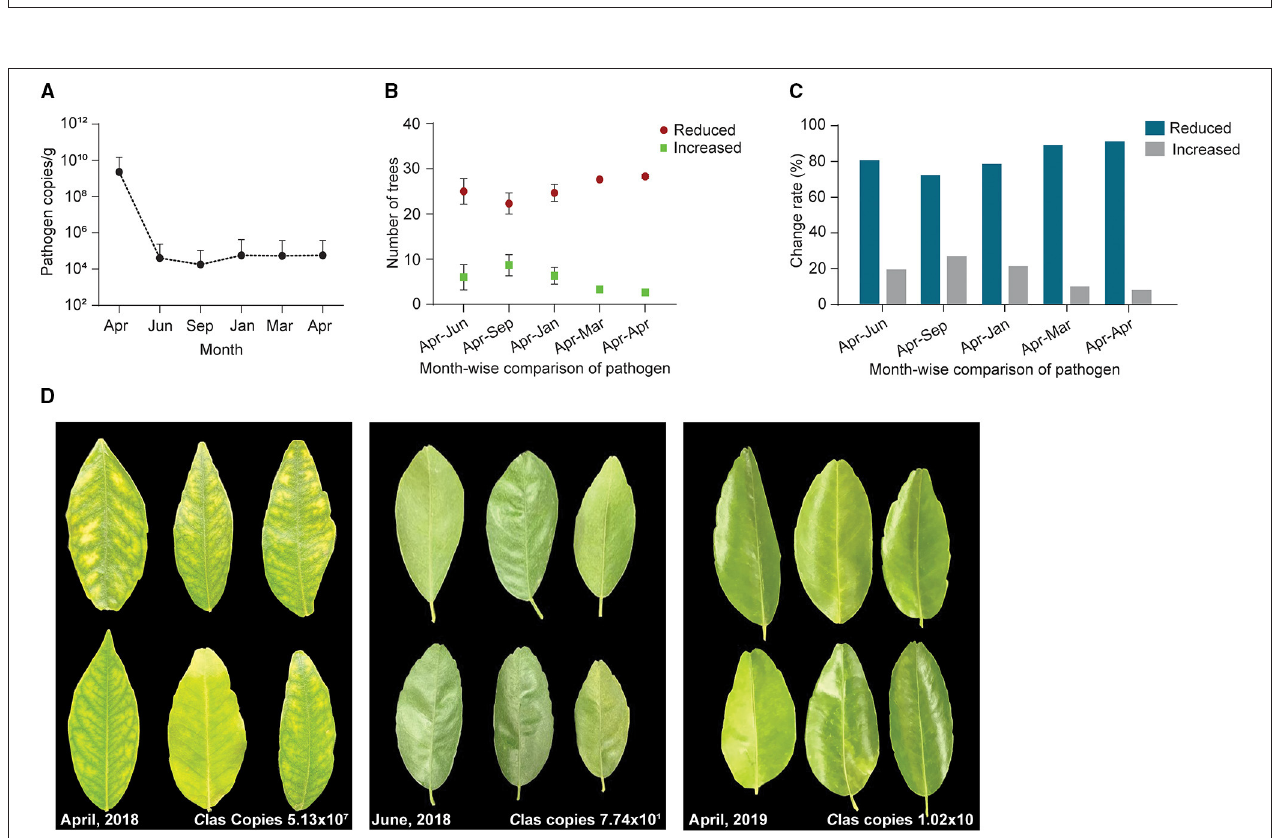
FIGURE 7 | A total of 93 citrus diseased sampled trees were treated with endophytes and C Las pathogen was monitored throughout the study period from April 2018 to April 2019. (A) CT values obtained through qPCR were changed to pathogen copies per gram of citrus leaf using a standard curve generated from pUC18-382 recombinant plasmid; (B) Number of citrus trees displayed a reduction of C Las pathogen during different time intervals, April to September 2018 and January, March, and April 2019. Each repeat contains 31 citrus trees; (C) Percentage reduction of pathogen across month-wise indicating reduction of the pathogen from time to time; and (D) Citrus leaves showing yellow symptoms before application of endophytes (April 2018) to more greenish leaves with the different time intervals decreasing pathogen copies 10 7 to 10 C Las/gram citrus leaf midribs.